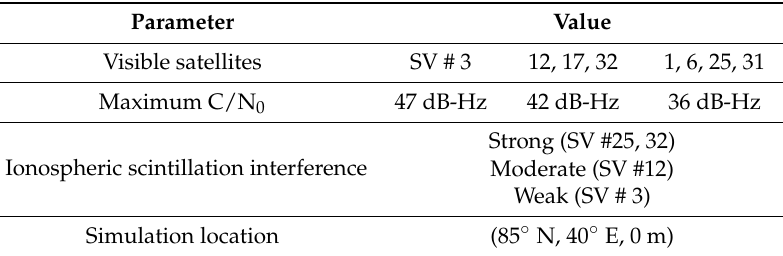
plot (mean PDOP: 3.0133)